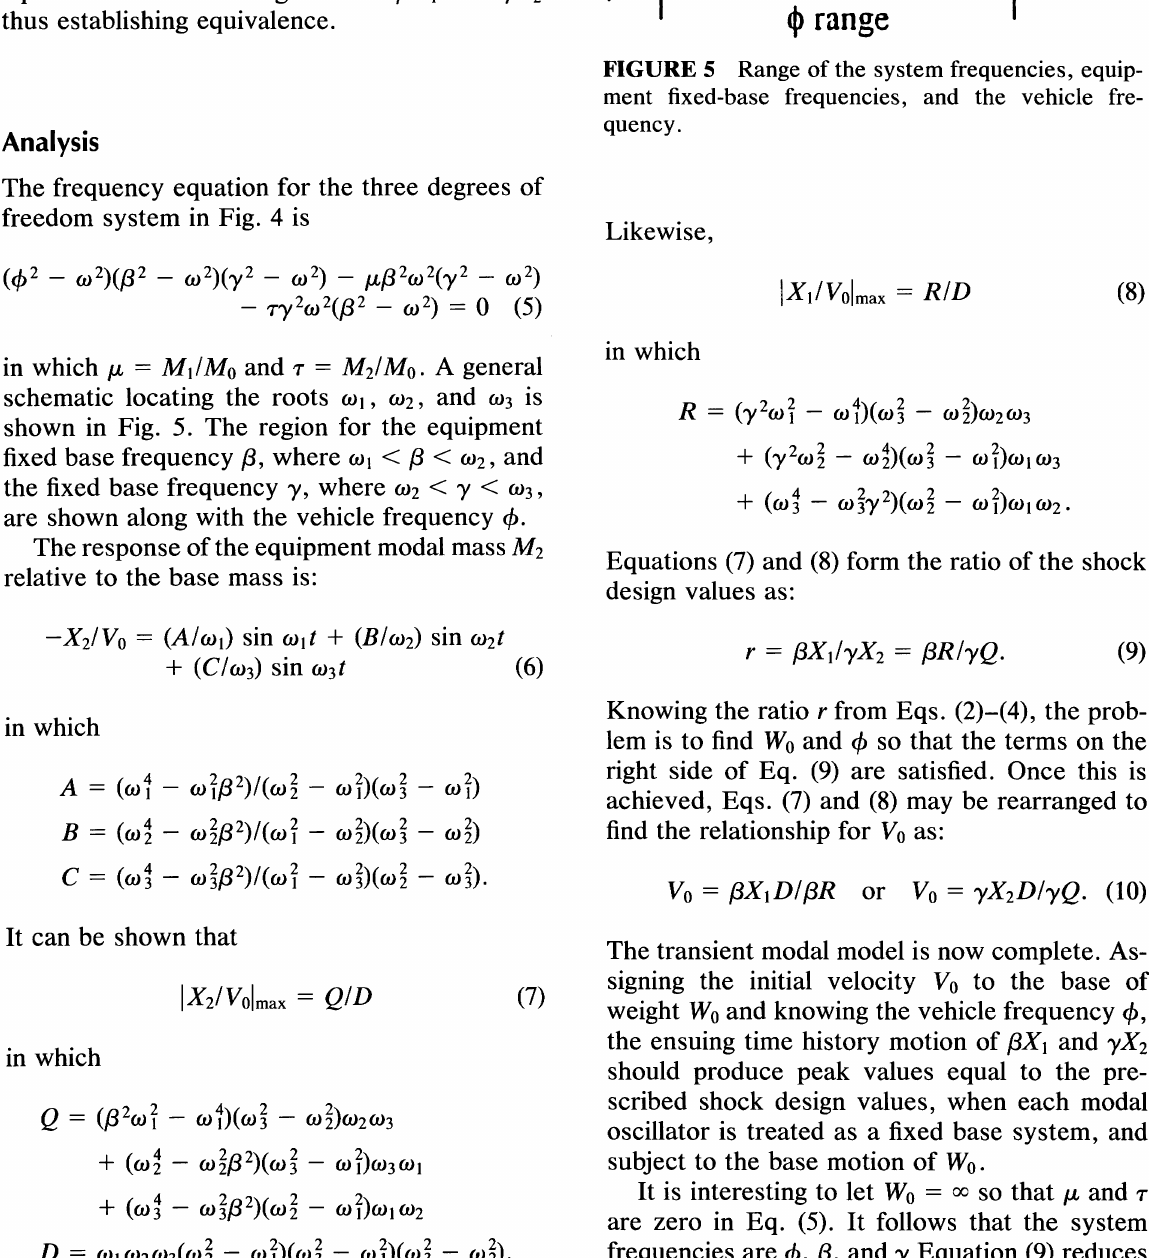
cp range FIGURE 5 Range of the system frequencies, equip ment fixed-base frequencies, and the vehicle fre